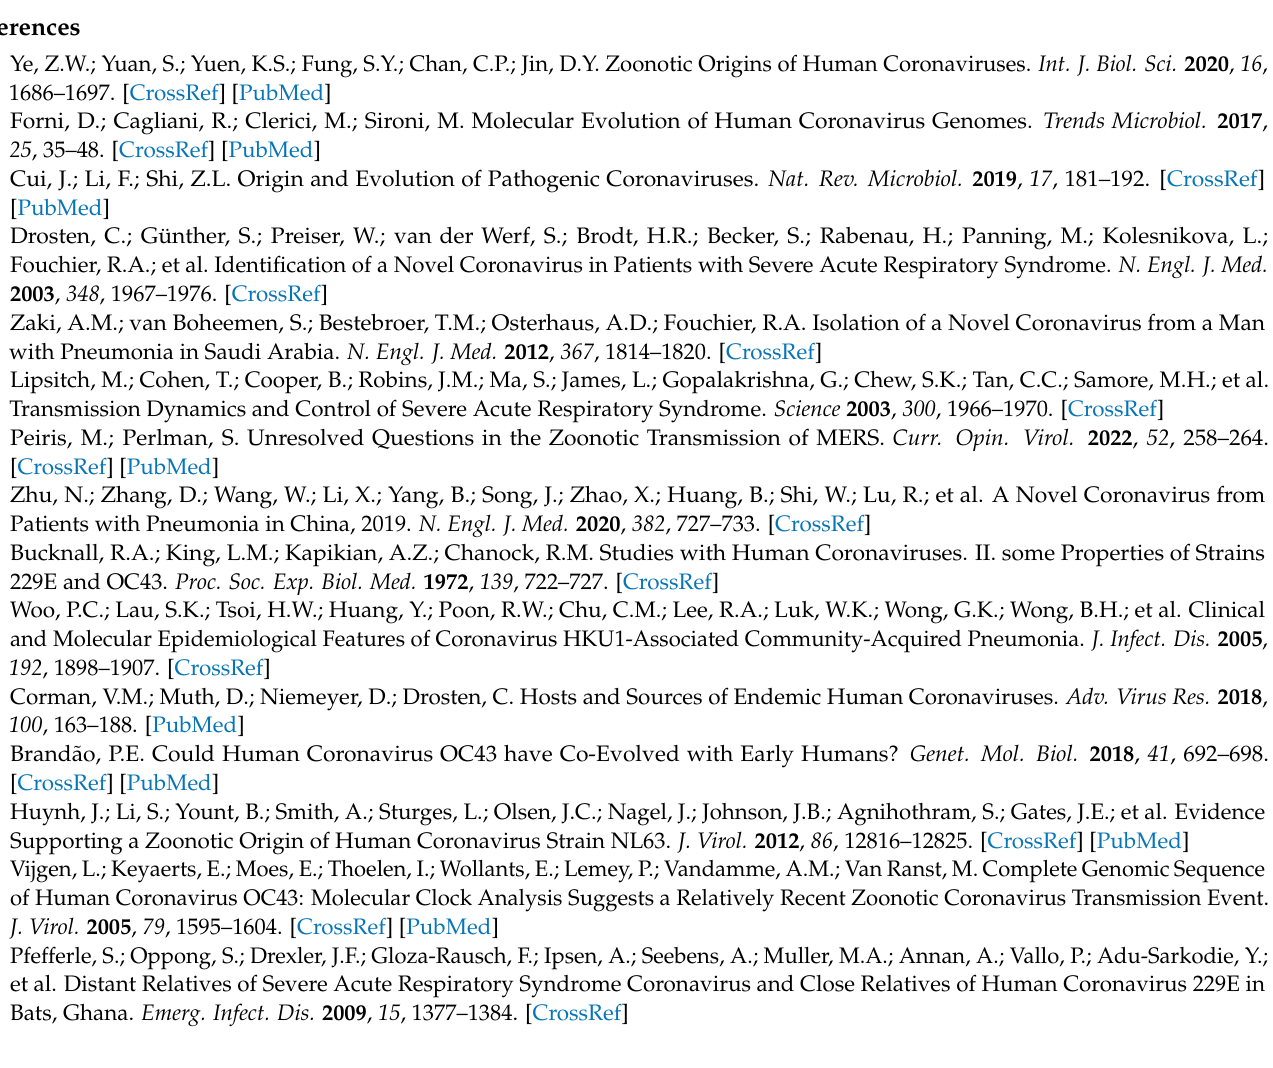
Table S2. Model comparison using BEAST (v.1.10.4) path sampling. Figure S1. HCoV-NL63 and HCoV-HKU1 timescaled phylogenetic